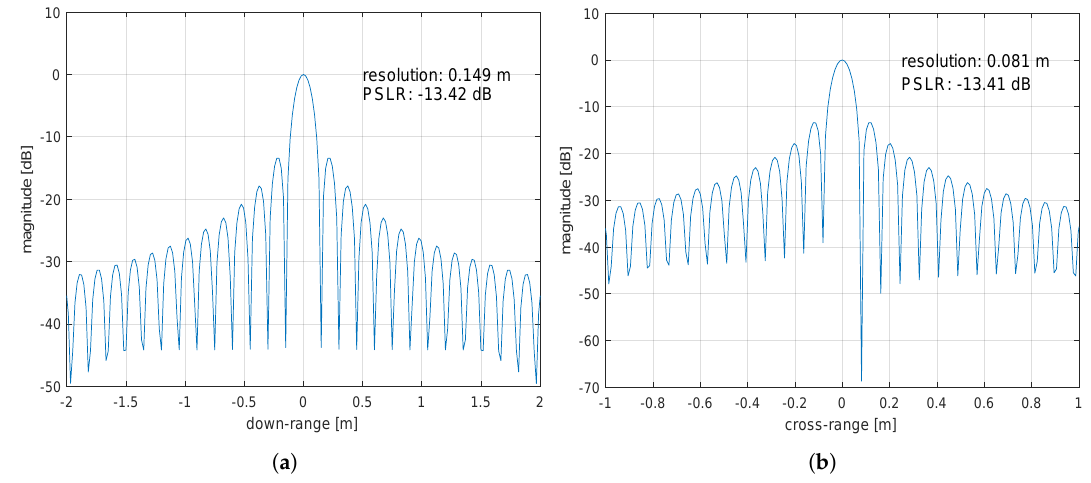
Figure 16. Impulse response analysis ( a ) in down-range; ( b ) in cross-range. PSLR: peak sidelobe